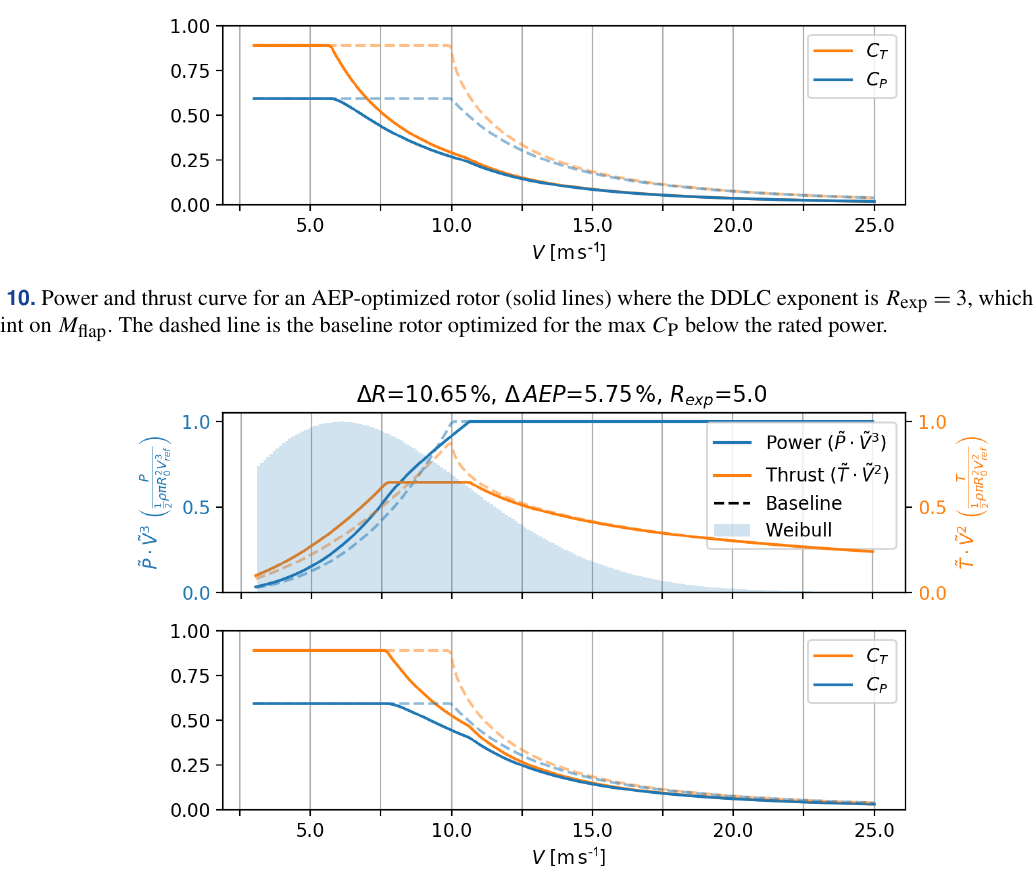
Figure 11. Power and thrust curve for an AEP-optimized rotor (solid lines) where the DDLC exponent is R exp = 5, which is equivalent to a constraint on δ tip . The dashed line is the baseline rotor optimized for the max C P below the rated